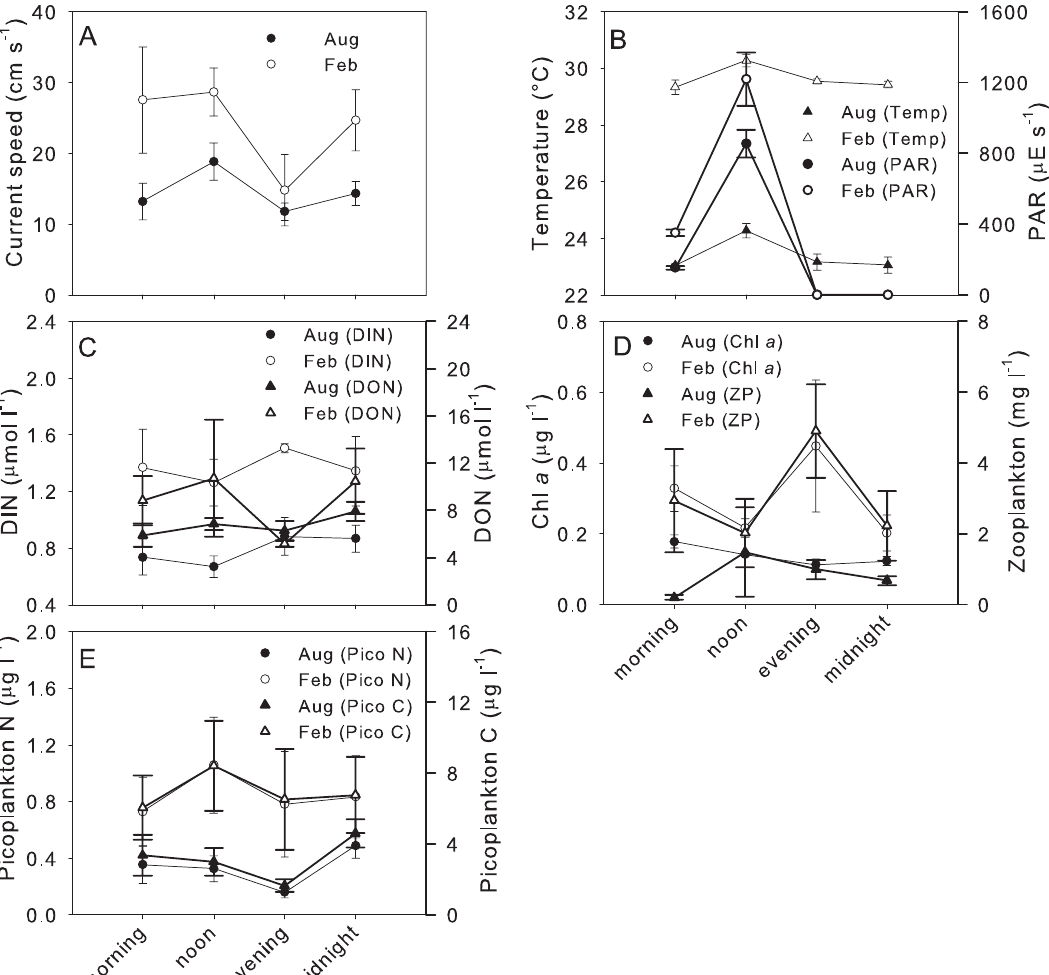
Figure 4. Diel patterns for physico-chemical parameters at Ningaloo Reef. Patterns in (A) current speed (B) temperature and light intensity, (C) dissolved inorganic nitrogen (DIN) and organic nitrogen (ON), (D) Chlorophyll a concentrations and zooplankton and (E) picoplankton carbon and nitrogen content at station 4 during August 2010 and February 2011. Data are means 6 SE (n=4).